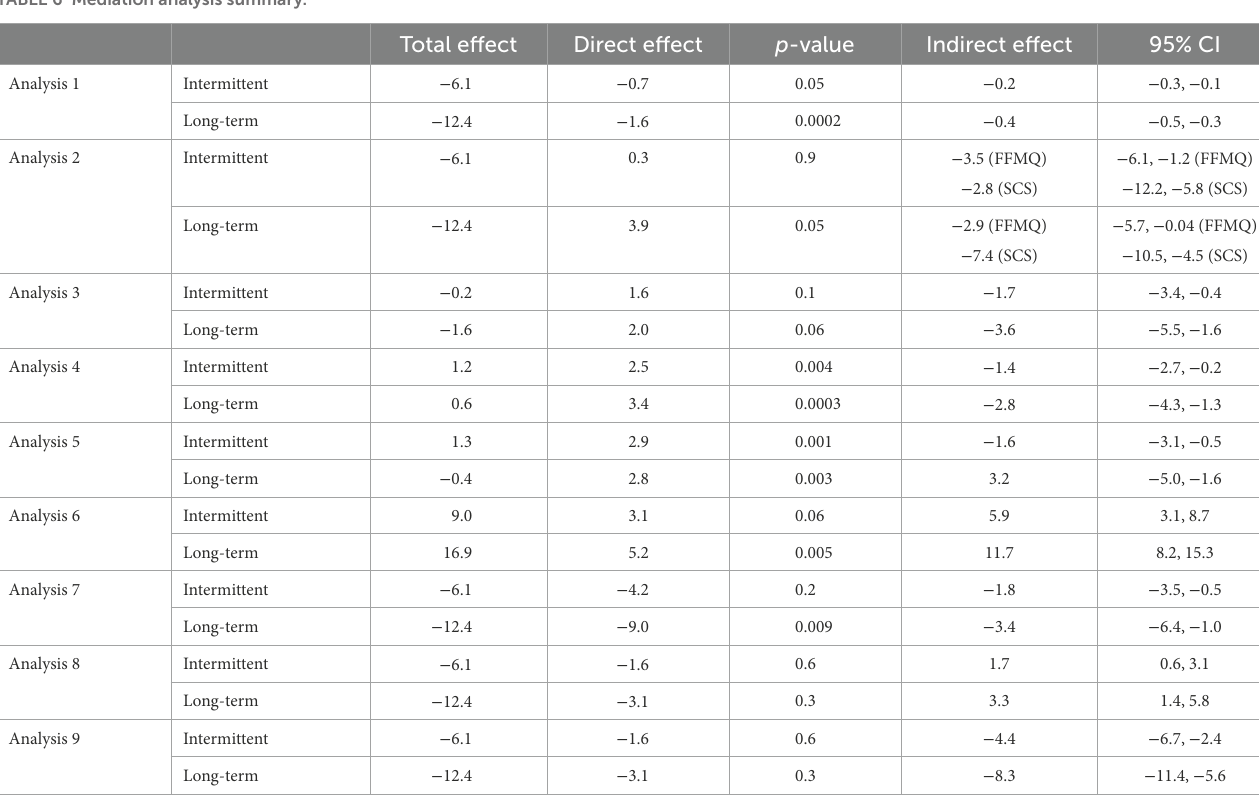
TABLE 6 Mediation analysis